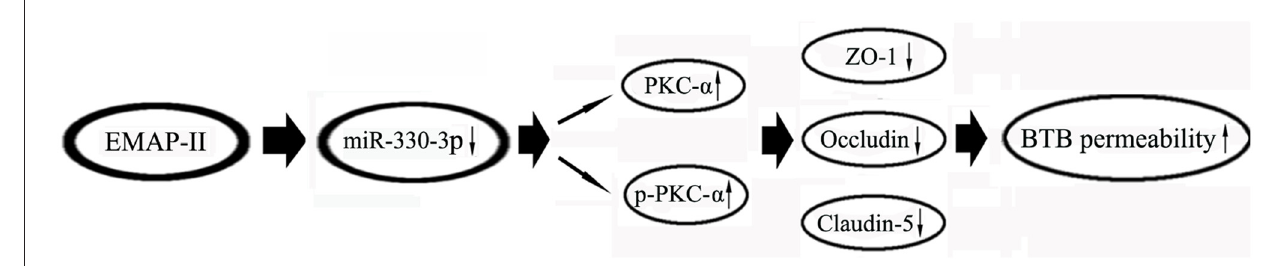
FIGURE 9 | The schematic cartoon of EMAP-II increasing the BTB